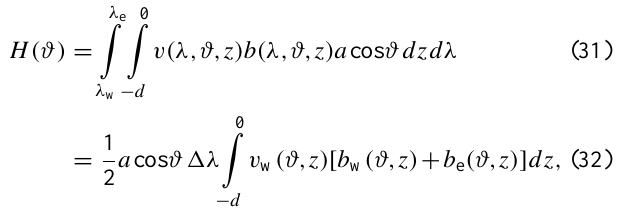
the large advective buoyancy transport accomplished by the poleward surface current destabilizes the water column. As surface buoyancy is fixed, convective mixing occurs and ad- justs the entire upper ocean to surface properties. The depth of this convective layer increases with latitude. At constant depth, buoyancy decreases with latitude ev- erywhere at the western boundary. This is not true for the eastern boundary, where near-surface downwelling advects relatively buoyant surface waters, resulting in nearly neutral stratification reaching deeper than at the western boundary (Fig. 5b). As a consequence, isopycnals slope downward with latitude before they steeply outcrop, forming a bowl- type structure. Note that, although stratification is nearly neutral, convective mixing is not present in this outcropping region. 2 2 Artificial horizontal diffusion can also render the stratification unstable at the eastern boundary. When that occurs, it is compen- sated for by weak convective mixing. Being a numerical artefact, this process is disregarded in the